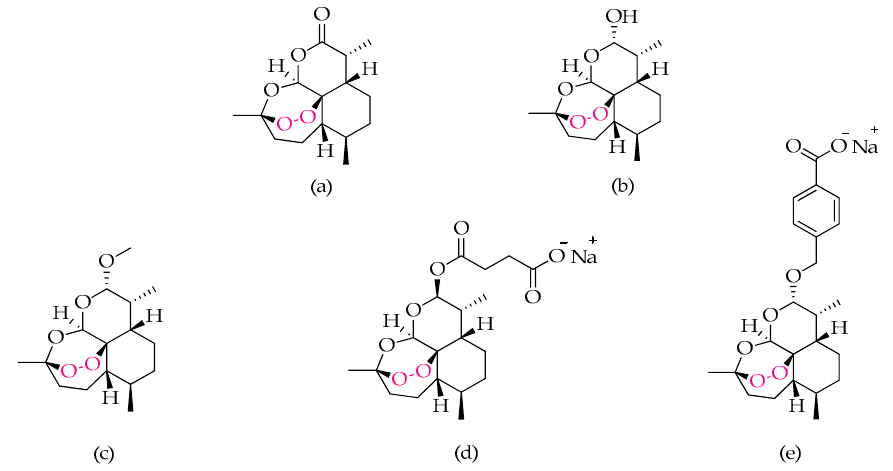
Figure 3. Structural representation of endoperoxides used as antimalarials: artemisinin ( a ), dihydroartemisinin ( b ), artemether ( c ), artesunate ( d ), and artelinate ( e ), highlighting the peroxide bond.